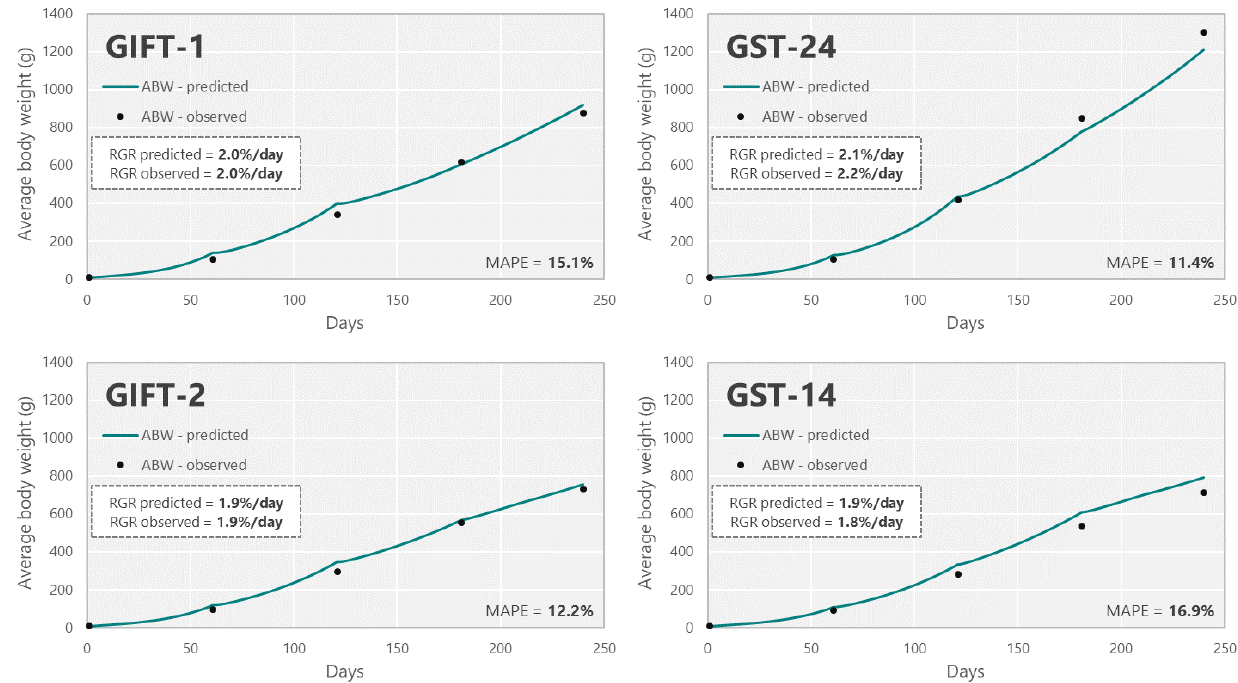
Figure 4. Time series of predicted (solid line) and observed (points) average body weight (ABW) for the dos Santos et al. [31] data set, which includes experimental data about different Nile tilapia strains (i.e., GIFT-1, GST-24, GIFT-2, GST-14) reared under similar conditions. MAPE stands for mean absolute percentage error (%) and RGR for relative growth rate (%/day), the latter calculated as: 𝑅𝐺𝑅 = (𝑒 (𝑙𝑛(𝐴𝐵𝑊 𝑖+𝑛 )−𝑙𝑛(𝐴𝐵𝑊 𝑖 ))/(𝑑𝑎𝑦 𝑖+𝑛 −𝑑𝑎𝑦 𝑖 ) − 1) × 100 .